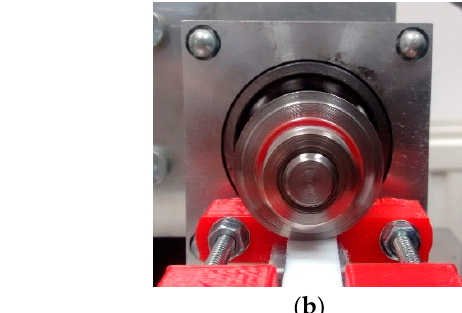
Figure 6. Imprint obtained from the Knoop microhardness test. Shimadzu HMV-2 microhardness tester was used during the research. The measurements were carried out by maintaining the samples in a deformed state using a grip (Figure 7). For the Knoop microhardness measurements, the lowest load (98.07 mN) and the lowest load time (5 s) were used. The measured diagonal lengths of the indentations ranged from about 170 µm (for undeformed material) to about 220 µm (for deformed material). Using the known angle of the indenter (172°30 ′ )